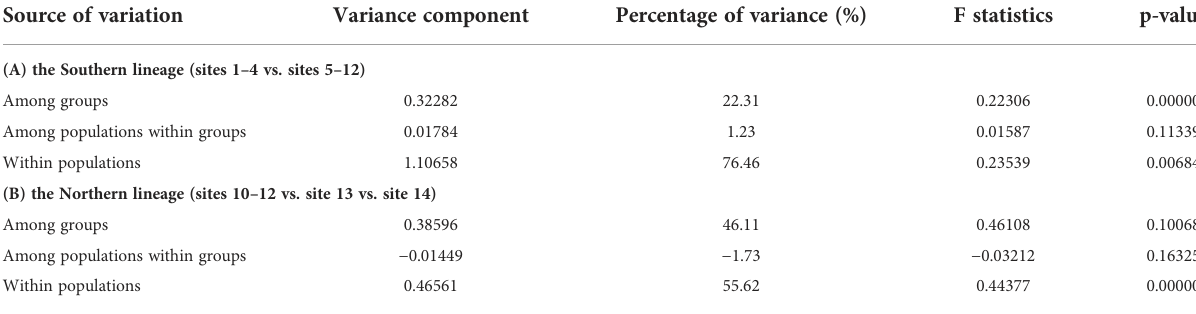
TABLE 1 AMOVA for the southern and northern lineages of T. barbatus with best partition strategies selected by SAMOVA. Source of variation Variance component Percentage of variance (%) F statistics